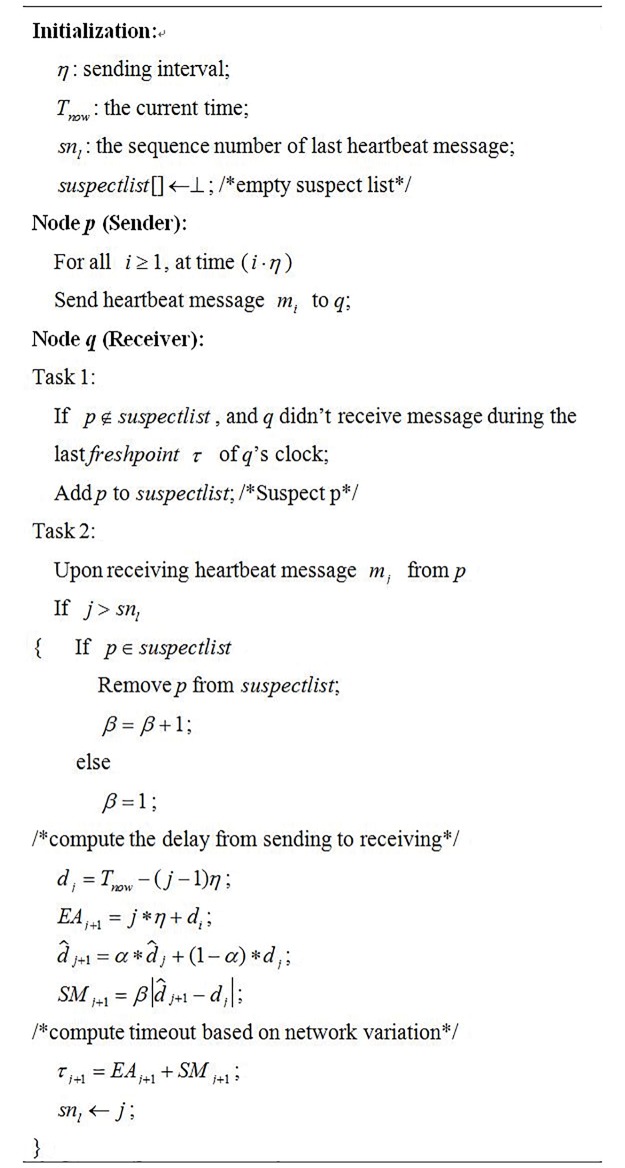
2E-FD algorithm.